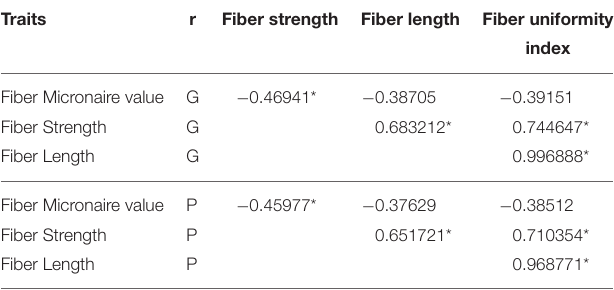
TABLE 2 | Genotypic (G) and Phenotypic (P) correlation matrix for quality traits (fiber length, fiber strength, and fiber micronaire value and fiber uniformity index) of transgenic